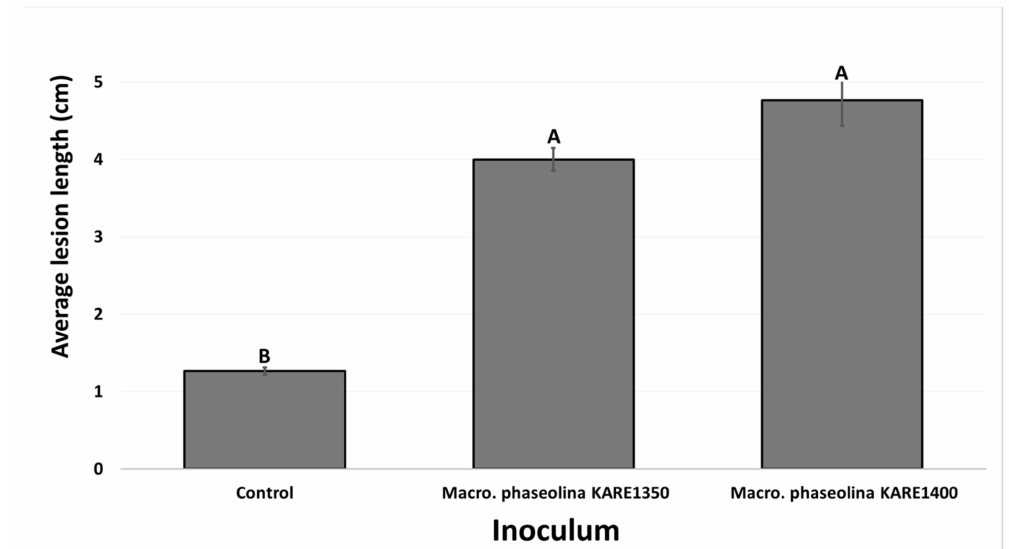
Figure 5. Average lesion lengths (cm) on pistachio clonal UCBI rootstocks 10 months after inoculation with mycelial plugs of Macrophomina phaseolina isolates KARE1350 and KARE1400 (September 2016 inoculations). Columns with different letters indicate treatment means that are significantly different ( p = 0.0005).